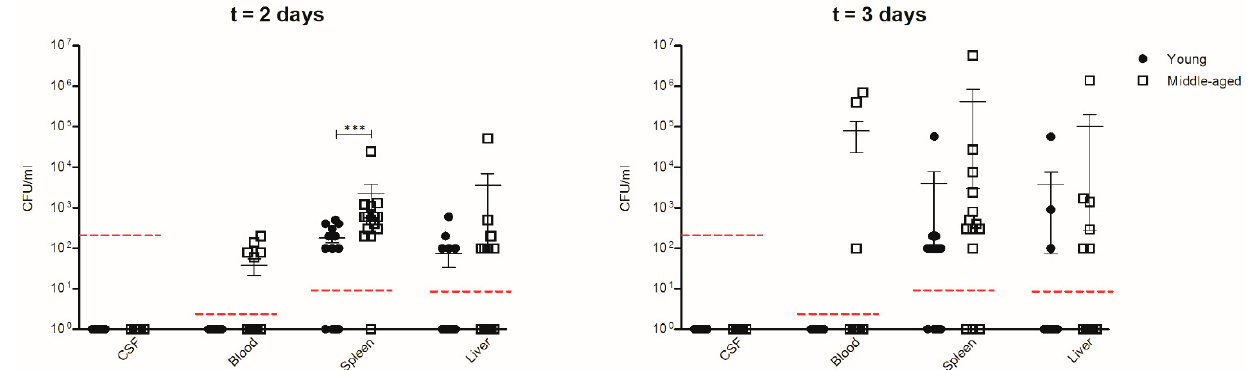
Figure A3. Weight difference per time point in percentage. Student t -tests were performed, data represent mean ± SEM, * p ≤ 0.05, ** p ≤ 0.01, *** p ≤ 0.001, **** p ≤ 0.0001.